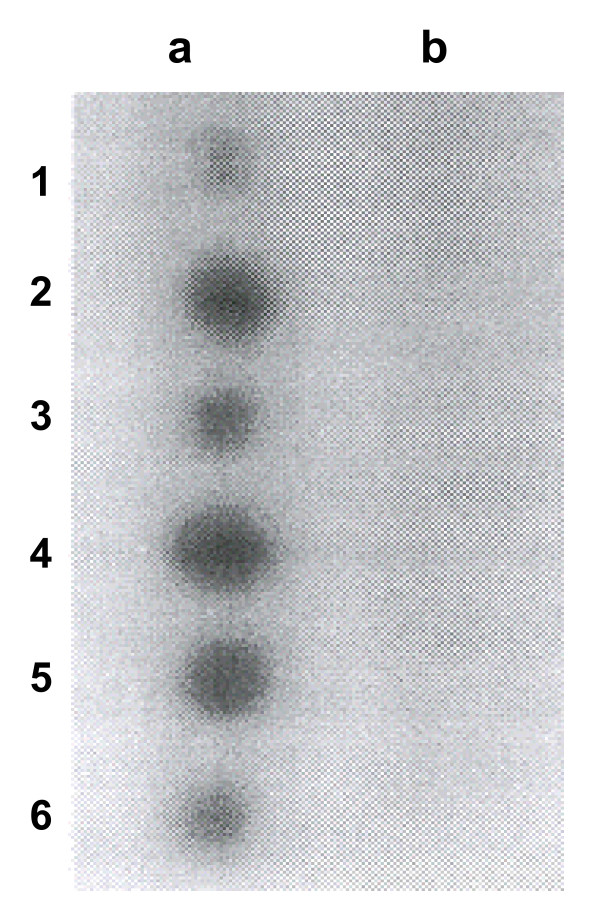
Binding assay of rhu 125I-IFN-γ labeled to recombinant chimeric protein using dot blot analysis. 1 μl aliquots of the eluted fractions from the gel filtration chromatography (rows 1, 2, 3, 4, 5, 6) were applied to nitrocellulose membrane strips. The strips were incubated with IFN-γ labeled with 125I (35 μCi/μg) in the absence (lane a) and in the presence (lane b) of 100 fold excess of human IFN-γ.